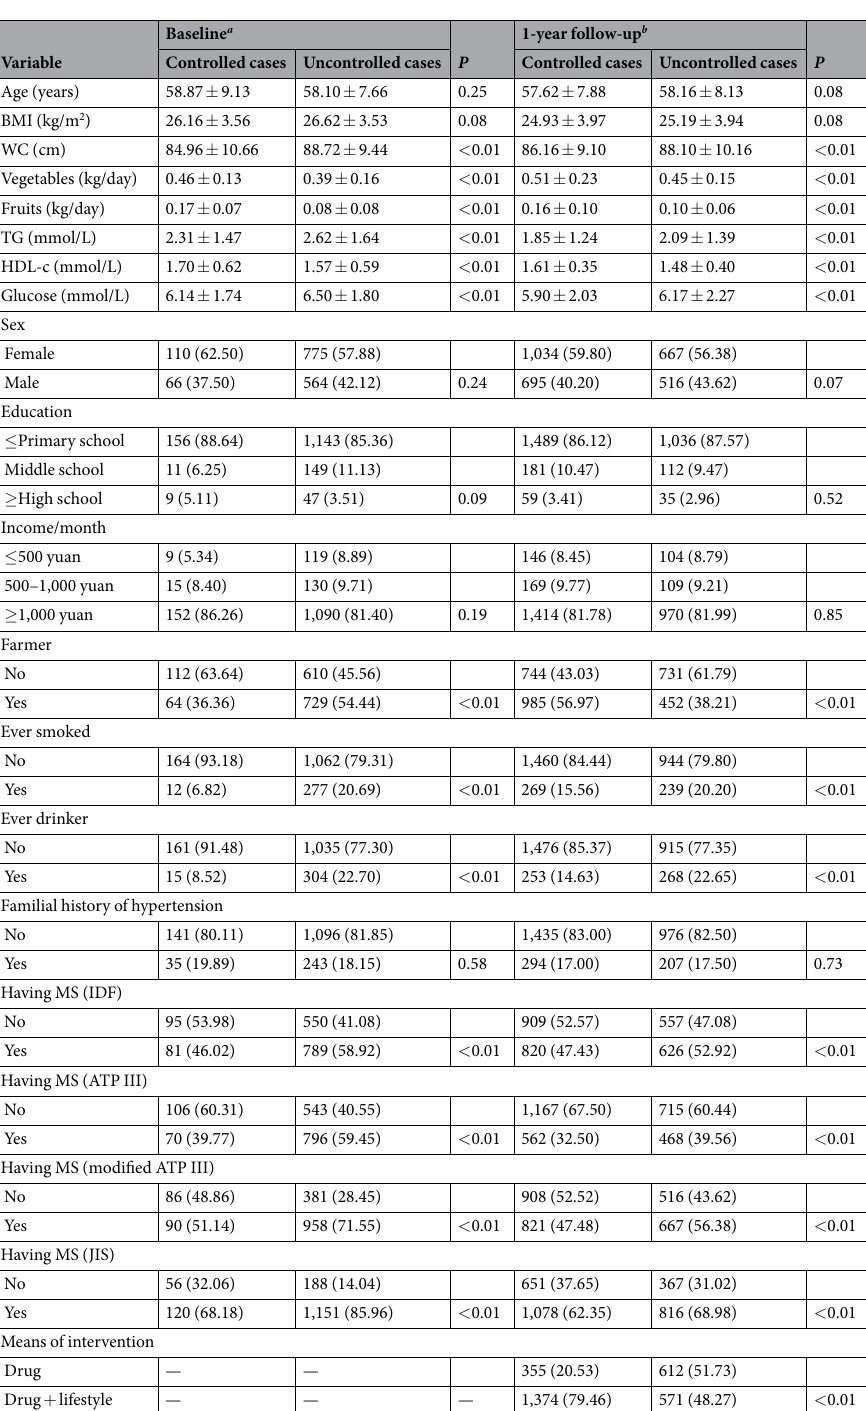
Table 4. Characteristics of cases with controlled or uncontrolled hypertension among patients receiving antihypertension therapy. WC: waist circumference, TG: triglycerides, HDL-c: high-density lipoprotein cholesterol, MS: metabolic syndrome, ATP III: the Adult Treatment Panel III (part of the 2001 US Third Report of the National Cholesterol Education Program), Modified ATP III: the 2004 modification of the ATP III for Asian populations, IDF: the 2005 criteria from the International Diabetes Federation, JIS: the 2009 criteria from the Joint Interim Statement. a 1,515 patients with hypertension who received drug therapy among the 2,912 patients at baseline, b 2,912 patients with hypertension who were all receiving antihypertension therapy at the 1-year follow-up. Data are shown as mean ± standard deviation or number